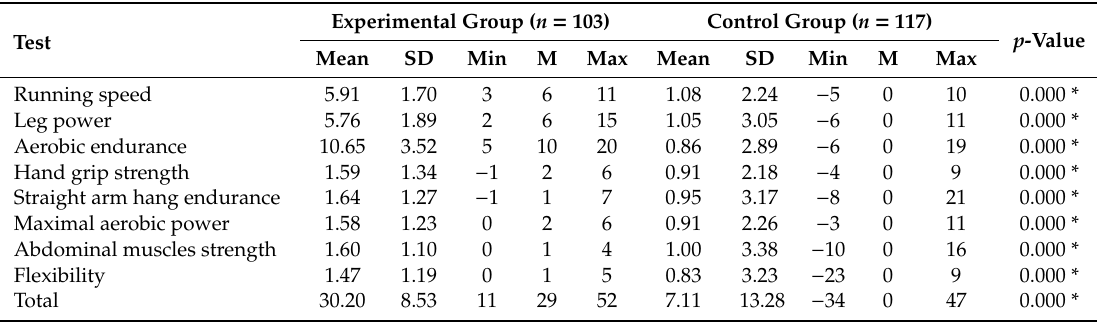
Table 2. Di ff erences between the results of the final and the initial measurement in the experimental and control